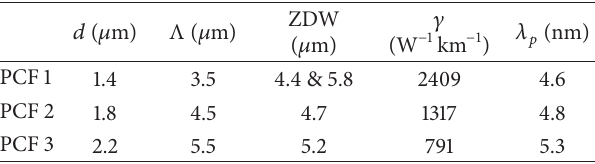
Table 1. The effective area and the nonlinear coefficients